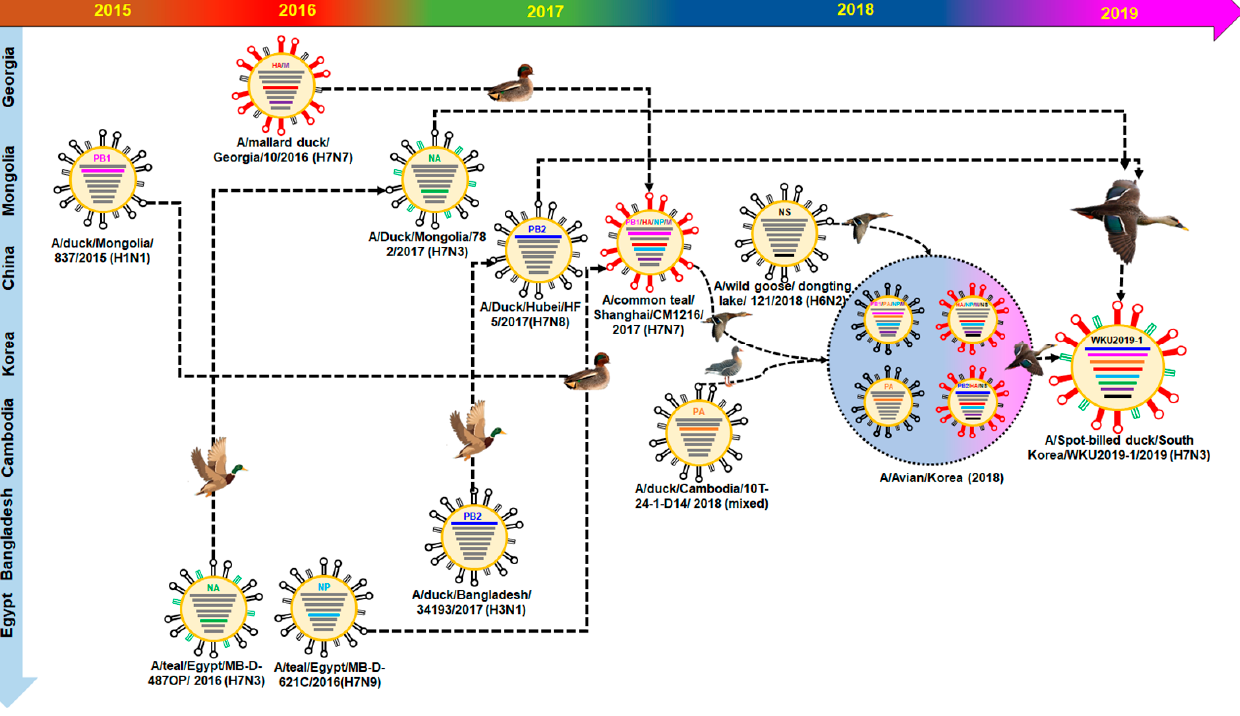
Figure 3. Original reassortment events of the novel avian influenza isolate H7N3 (WKU2019-1).